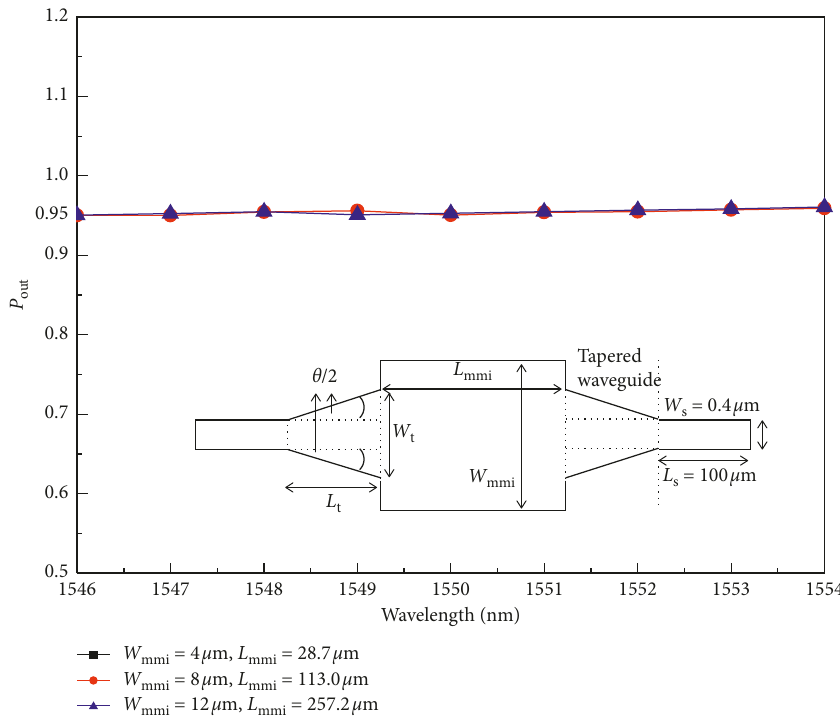
Figure 9: The spectral responses are insensitivity for the wavelength from 1546 to 1554nm with the step of 1nm under the condition of this linear tapered waveguide with a maximum divergence angle θ of 16 ° /14 ° /8 ° combined with the three different widths of a 1 × 1 MMI of 4 μ m/ 8 μ m/12 μ m, respectively.